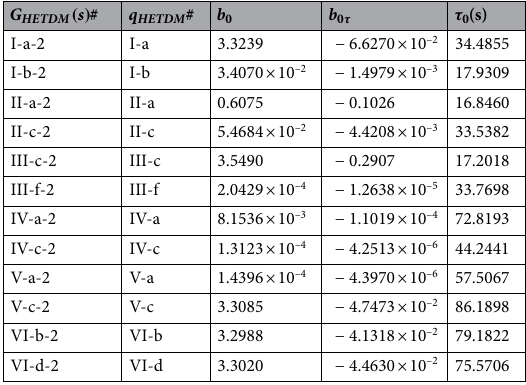
Table 9. HETDM transfer function numerator parameters computed via the NM